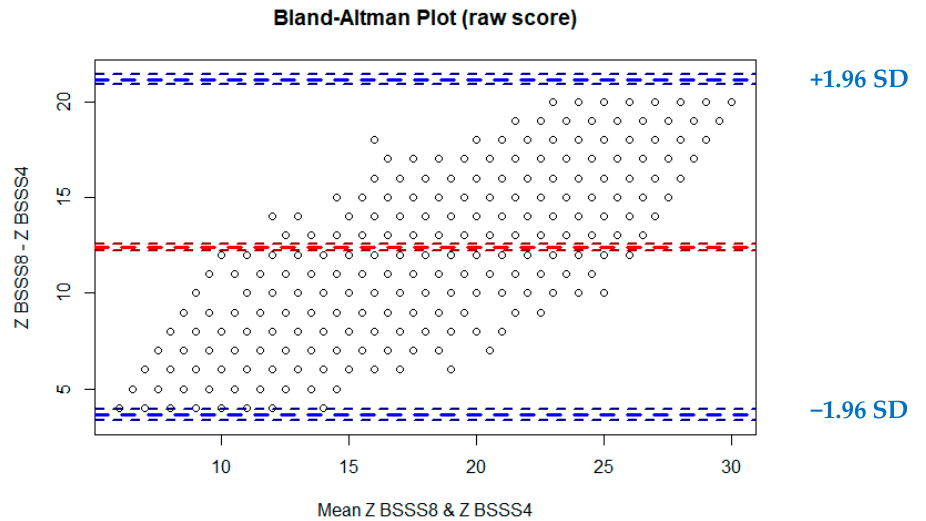
Figure 1. Bland–Altman plot of the z scores and raw scores of the BSSS8 and BSSS4. Z(BSSS8): Z score of the observed raw score on the BSSS-8. Z(BSSS4): Z score of observed raw score on the BSSS-4.